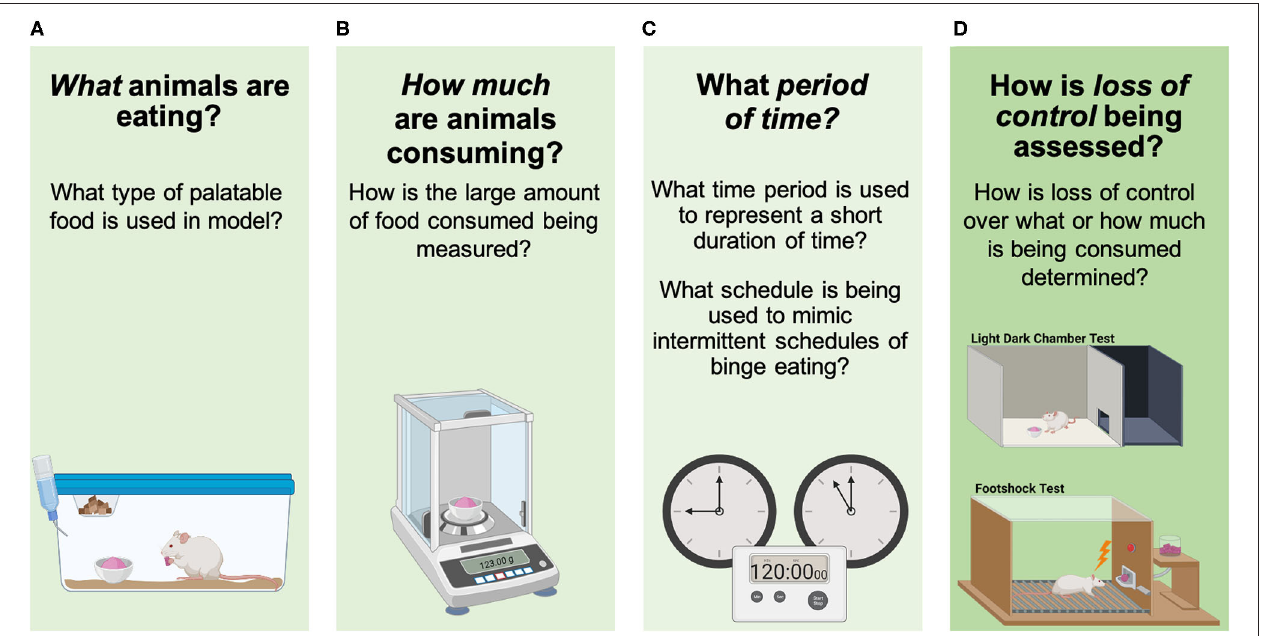
FIGURE 3 | Assessing components of binge eating in animals. (A) What animals are eating in the model (i.e., what type of palatable substance is being used), (B) how much animals are consuming (i.e., how is an “objectively large amount of food” being defined), (C) what period of time is being used to capture a BE episode (i.e., intermittent/short period of time being used to examine BE), and (D) how loss of control over eating during BE is being determined (i.e., loss of control over what/how much is being consumed). Images were created with